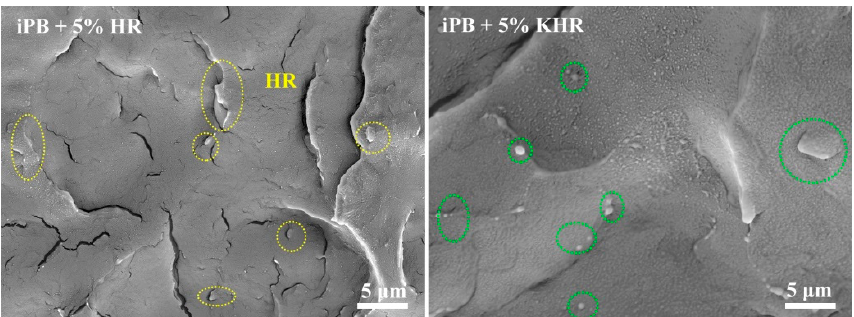
Figure 7. The SEM photographs of the fracture surface of the iPB/HR composite.